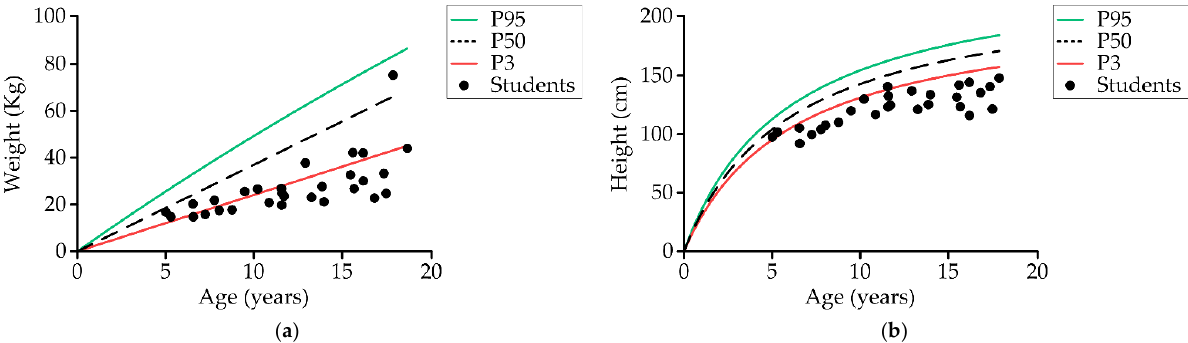
Figure 3. Relationship between student’s ( a ) weight and age, and ( b ) height and age compared to normal developing children reference population obtained from cross ‐ sectional study ( n = 29) [78]. Lower limit: weight in the third percentile; upper limit: weight in the 97th percentile. P95: 95th percentile; P50: 50th percentile; P3: third percentile.